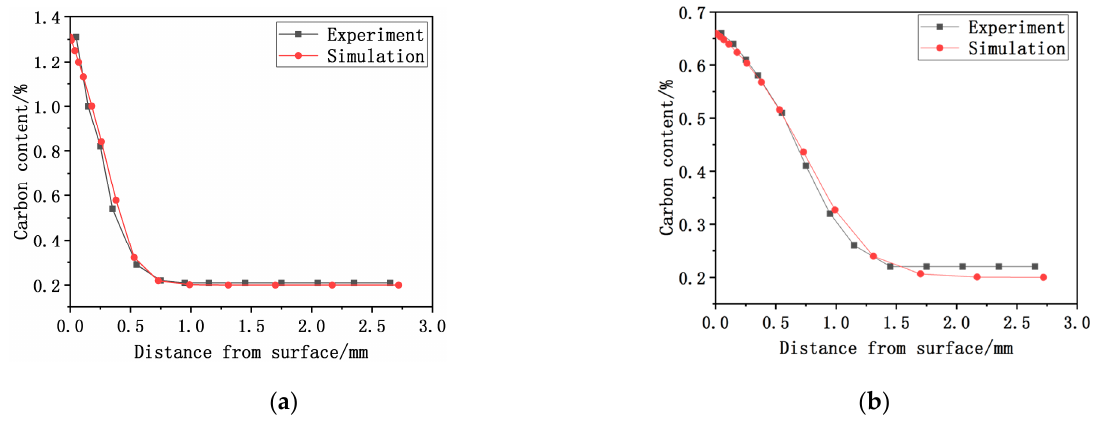
Figure 7. Comparison of experimental and simulated carbon concentration distribution curves. ( a ) Vacuum carburizing of process 1; ( b ) Vacuum carburizing of process 2.